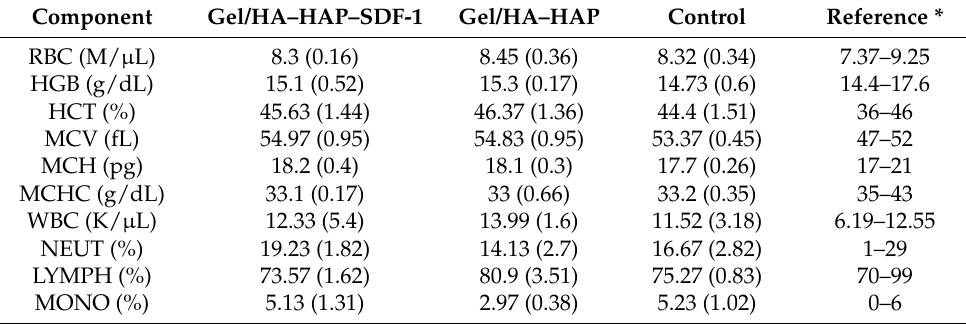
Table 1. Blood test (one month).